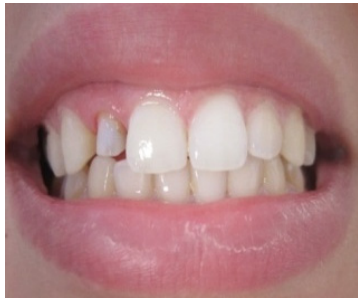
Figure 6. Aesthetic post and core system build up.